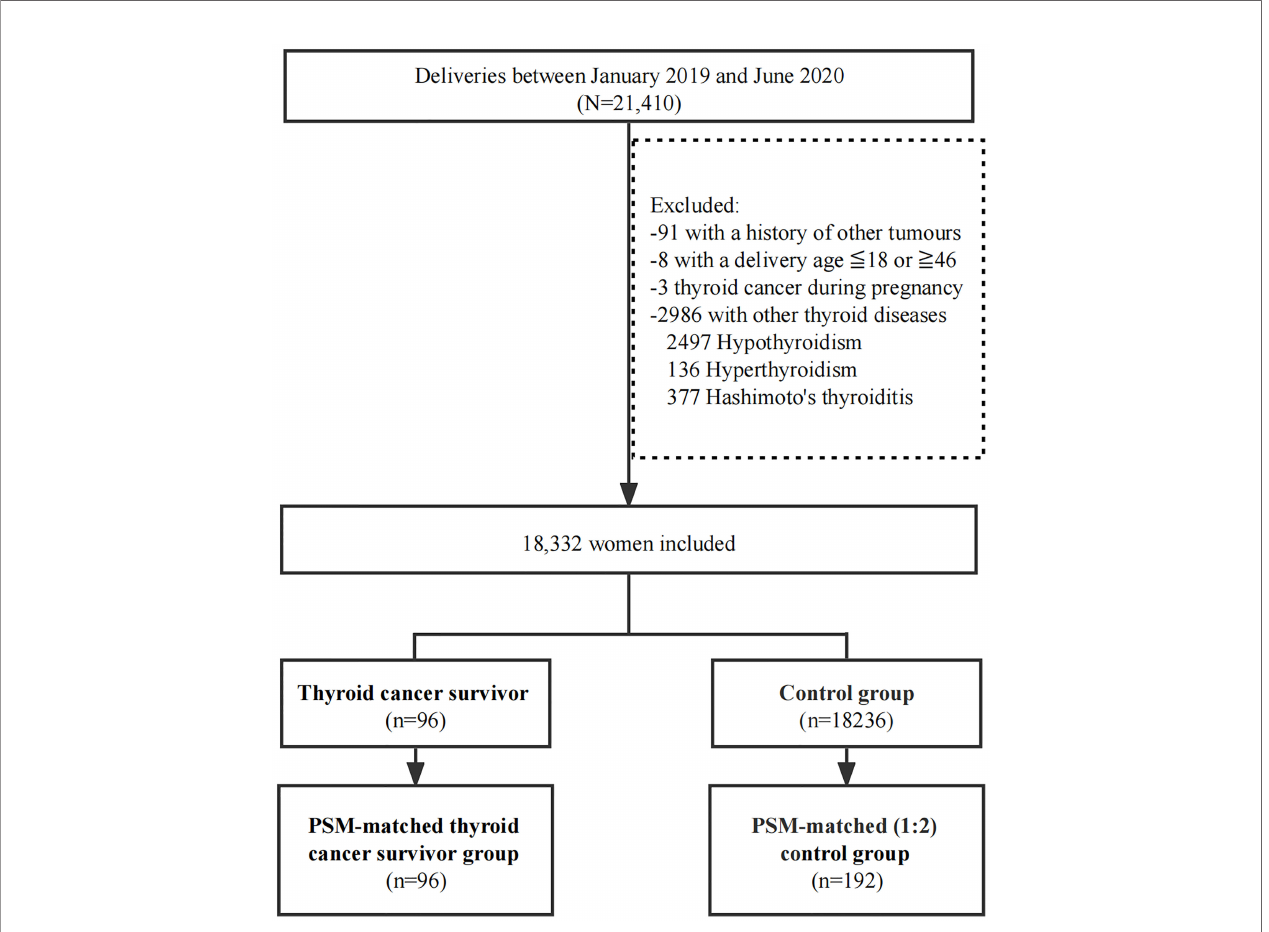
FIGURE 1 | The participants enrollment. PSM, propensity score